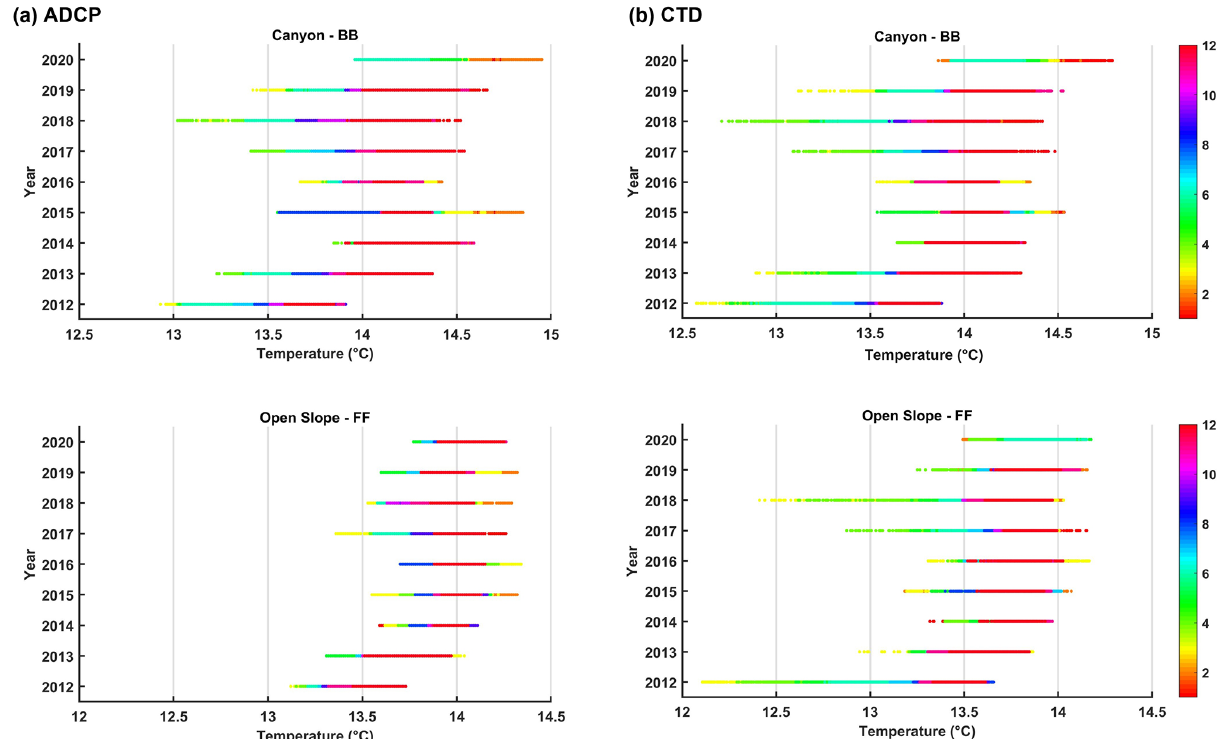
Figure 6. Scatterplot of ADCP (a) and CTD (b) temperature grouped by years ( y axis) and months (colour scale).